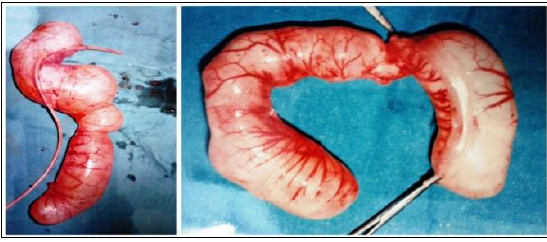
Figure 1: Gross pictures of resected ileal duplication cysts .